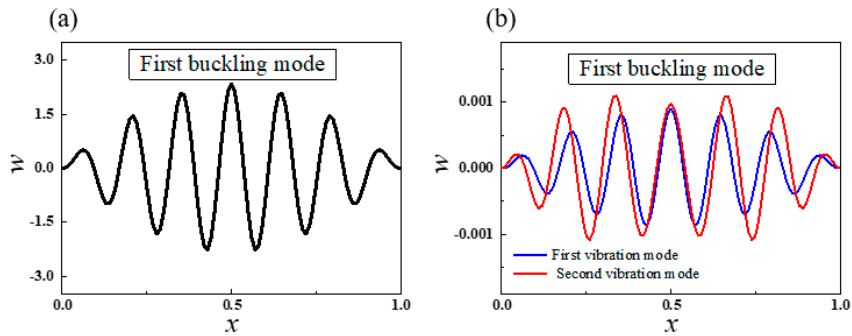
Figure 6. ( a ) The first order buckling mode and ( b ) the first order (blue line) and the second order (red line) vibration modes in the first buckling mode with substrate stiffness k = 3.38 × 10 6 when P = 5000.